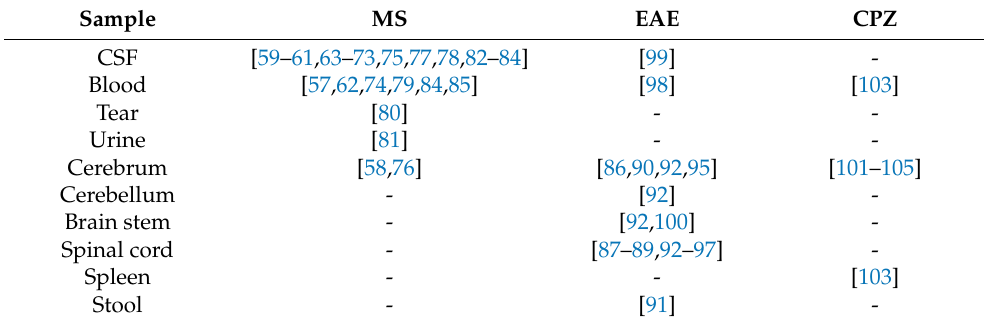
Table 1. Use of different biological samples in proteomic analyses of MS, EAE, and CPZ.